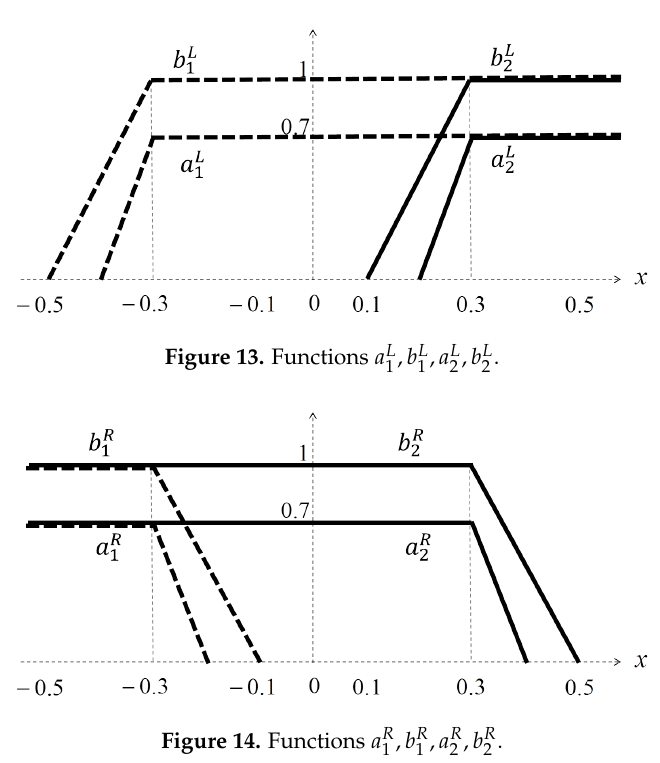
, b R , a R , b R 2 2 1 1